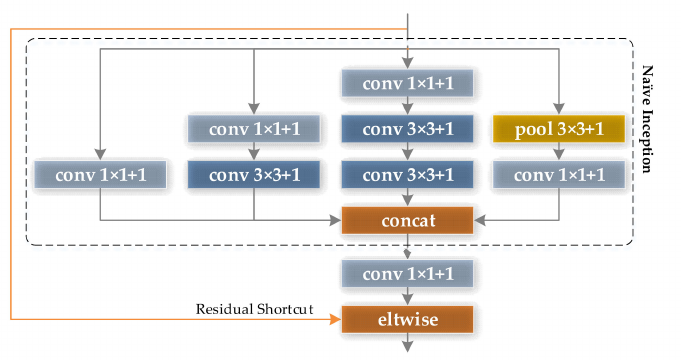
Figure 11. Optimized Inception feature extraction